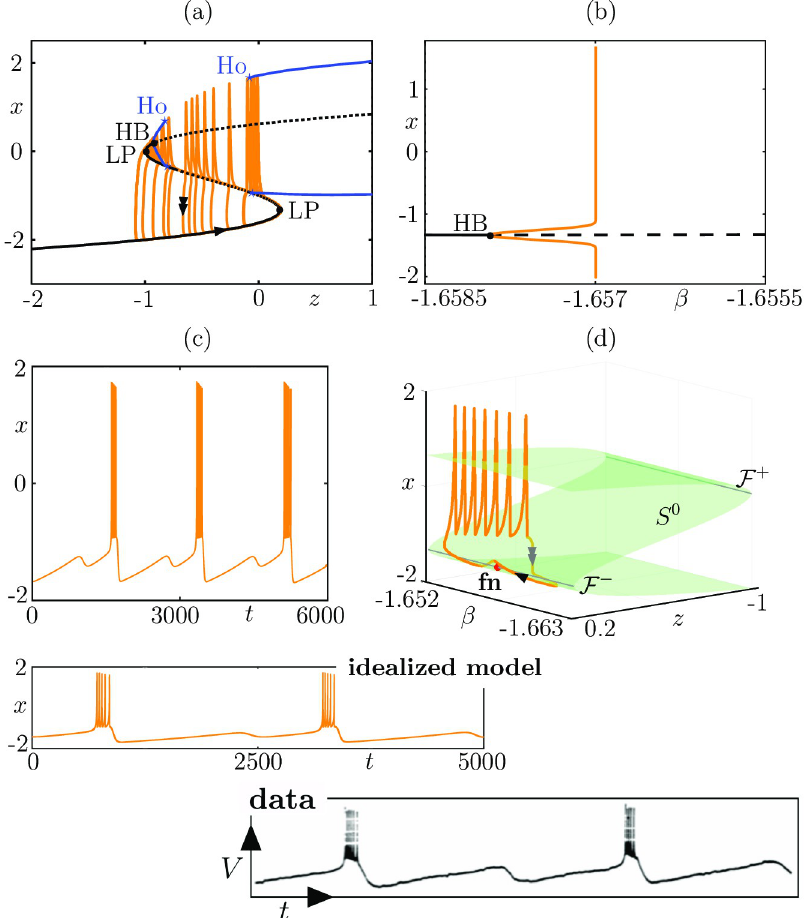
Fig 8. Folded-node/Homoclinic bursting. Panels (a-b) show the spike-adding transition in system (1): (a) in the ( z , x ) plane where we show several limit cycles for β -values exponentially close to − 1.656996 superimposed onto the fast subsystem bifurcation diagram; (b) bifurcation diagram of the associated 3D bursting system (1) with respect to parameter β , showing the sharp rise of the amplitude of the limit cycle branch (orange), corresponding to spike-adding transitions. Panels (c-d) show a folded-node/homoclinic bursting orbit in the extended 4D system (6): (c) in the ( β , z , x ) space (single/double arrows indicate slow/fast motion); (d) time course of the fast variable x . The bottom panels show a comparison between this folded-node bursting orbit from (6) and experimental data from [31]. Equations and parameter values are given in S1